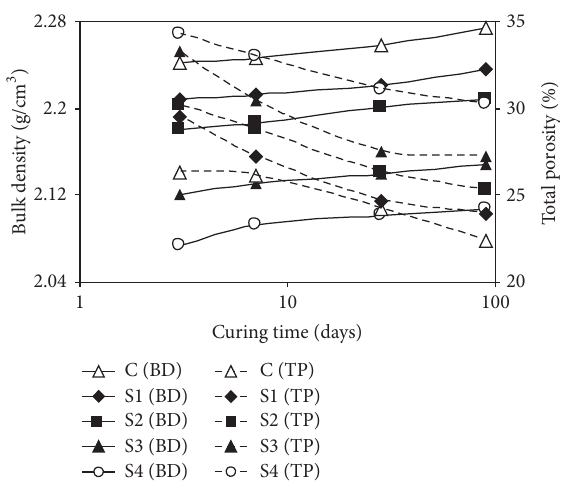
F 5: e bulk density and the total porosity of sewage sludge ash blended cement pastes.